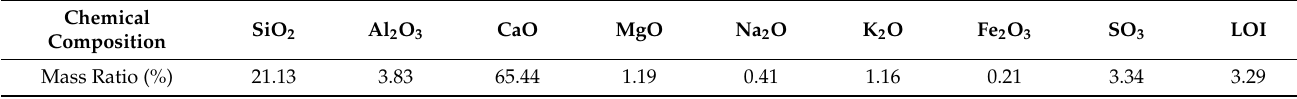
Table 1. The chemical composition of Albo white